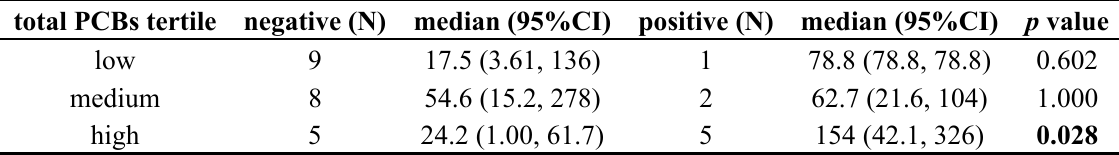
Table 3B. Association between milk specific IgE and IL-22 as analyzed by total PCBs tertile groups.